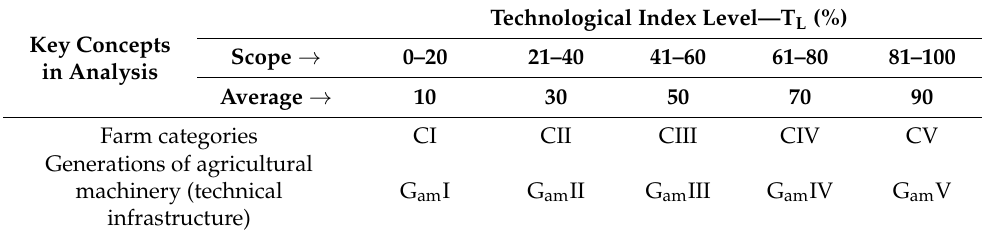
Table 1. Key concepts of analysis in connection with the technological index level (T L